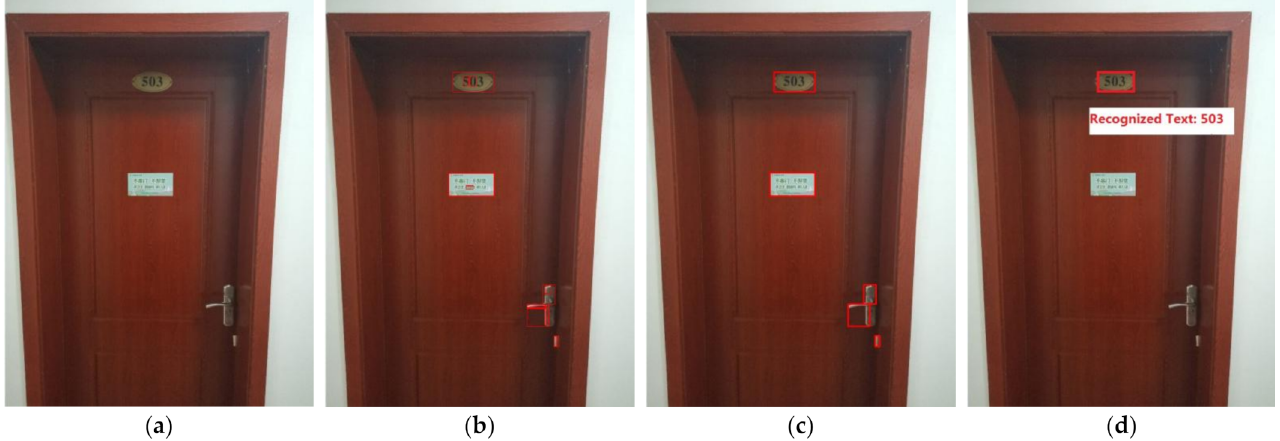
Figure 4. Illustration of text extraction. ( a ) Original image; ( b ) MSER; ( c ) MSER+NMS; ( d ) Recognition from Fixed